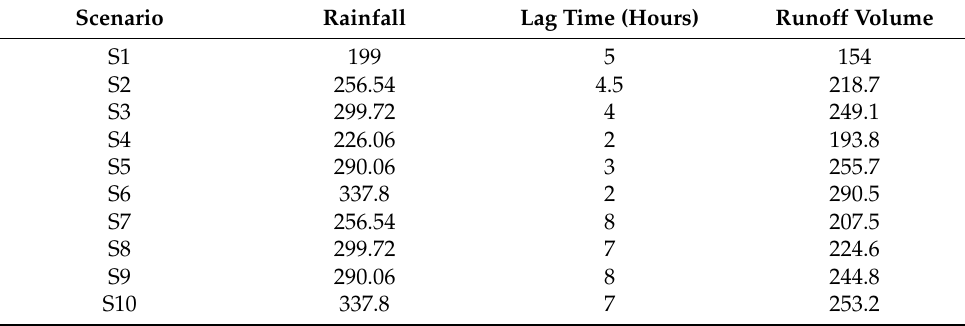
Table 3. Rainfall values, resulting runoff volumes, and lag time for different